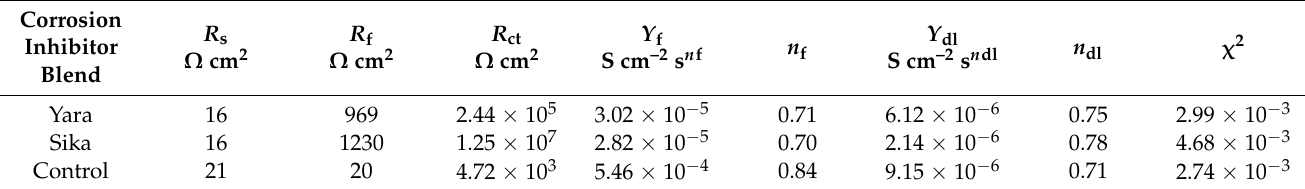
Table 4. The EIS parameters obtained for rebar exposed to commercial corrosion inhibitor blends (Sika and Yara) in simulated concrete pore solution with 0.6 M NaCl.